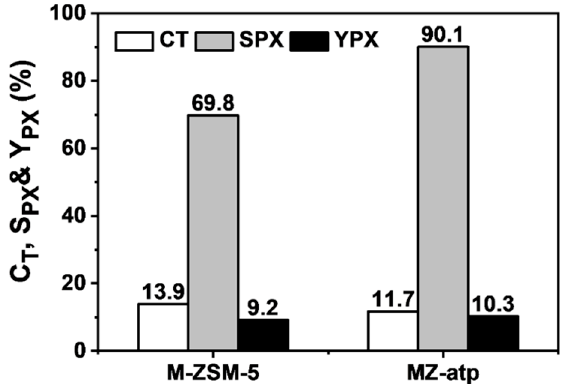
Figure 11. Toluene conversion, para-selectivity and yield of para-xylene over modified ZSM-5 (M- ZSM-5) and its extrudate with attapulgite (MZ-atp). Reaction conditions: 460 °C, atmospheric pressure, WHSV = 15 h − 1 , nT/nM = 4, nH 2 /n(T + M) = 2, nH 2 O/n(T + M) = 2.